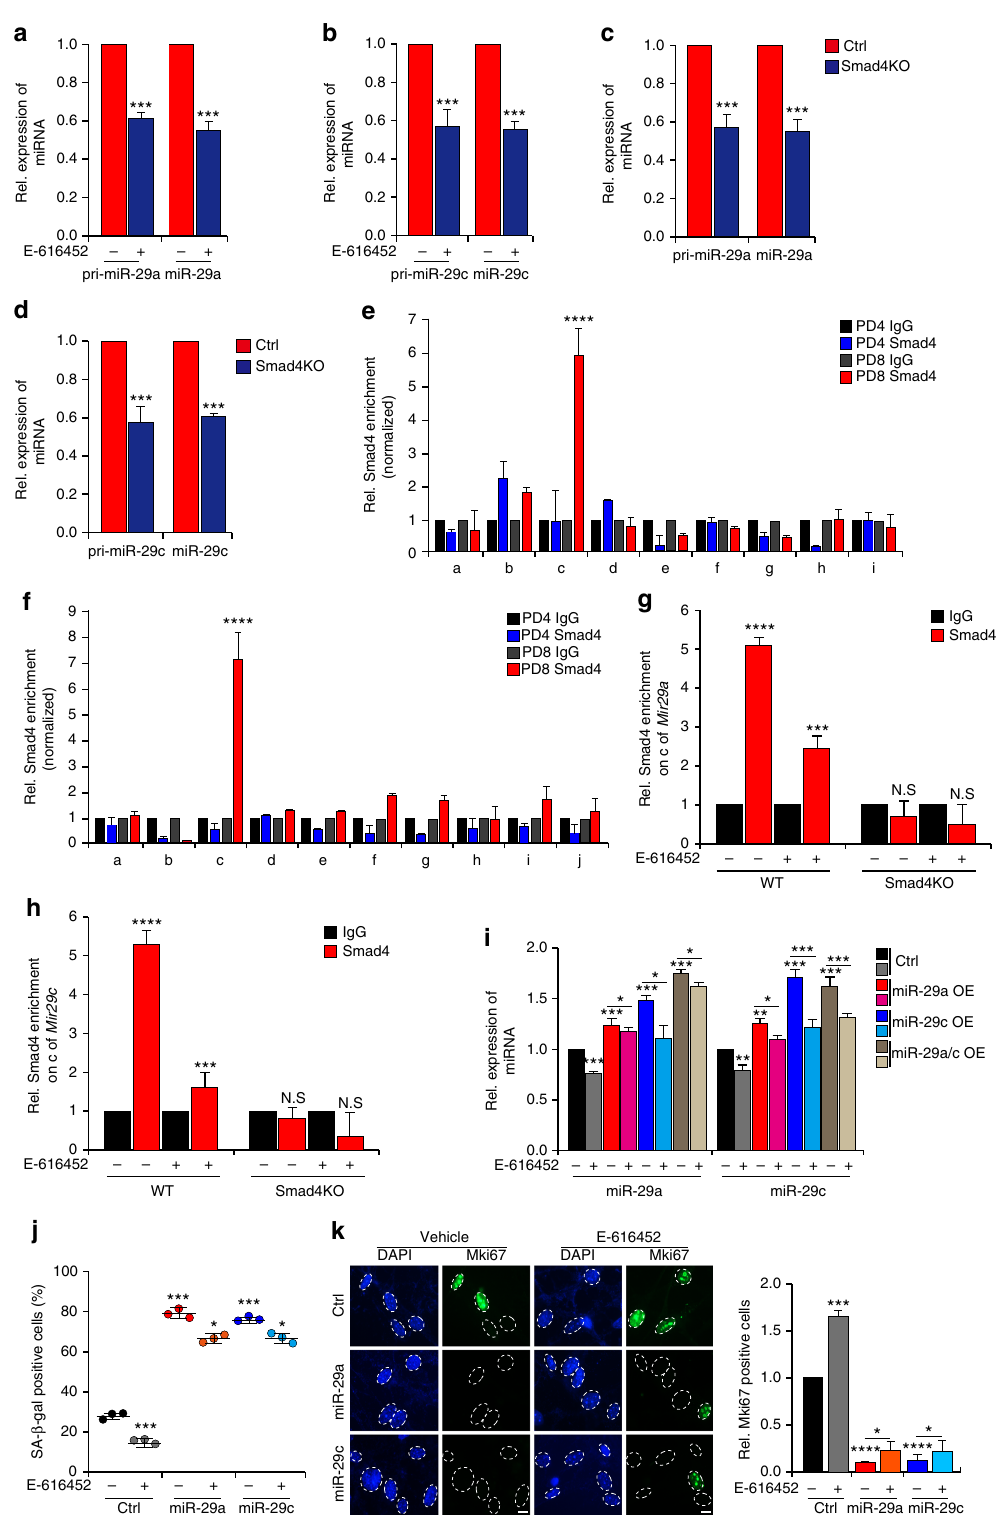
Fig. 3 TGF- β signaling regulates miR-29 expression in a Smad-dependent manner during MEFs senescence. a – d Quantitative real-time PCR for pri-miR-29 and miR-29 in MEFs incubated with E-616452 ( a , b ) or Smad4 knockout (Smad4KO) MEFs ( c , d ). e , f Chromatin immunoprecipitation-qPCR (ChIP-qPCR) assays of Smad4 from PD4 and PD8 MEFs. The x -axis represents the primer positons of the predicted promoters of Mir29a ( e ) and Mir29c ( f ). g , h Smad4 enrichment on Mir29a ( g ) and Mir29c ( h ) was measured in inhibitor-treated MEFs and Smad4KO MEFs. i MEFs with lentivirus-mediated expression of miR-29 were incubated with E-616452. Real-time PCR was used to measure miR-29 expression. j Diagrams showing SA- β -gal staining of MEFs collected from i . k Immuno fl uorescent staining showing the Mki67 signals in MEFs with the same treatment as those shown in i . Scale bar, 5 μ m. The error bars represent the s.d obtained from triplicate independent experiments. Two-tailed unpaired Student ’ s t -tests were performed, ** p < 0.01, *** p <